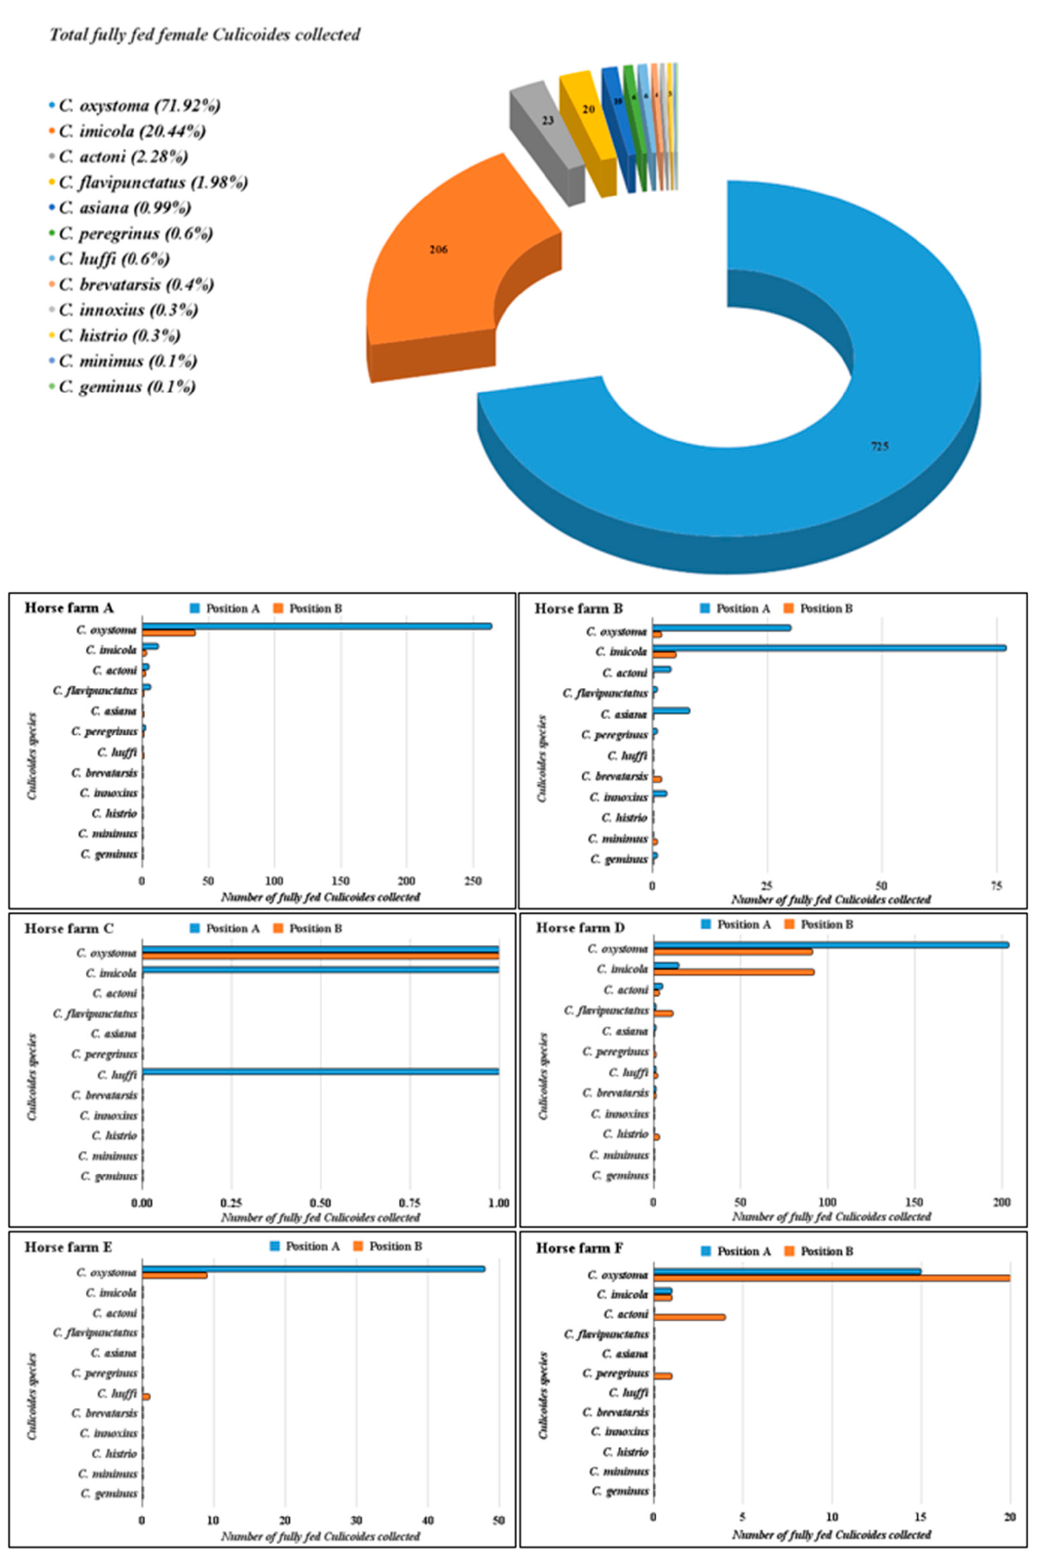
Figure 2. Number of Culicoides species collected from two positions at each horse farm in Hua Hin district, Prachuab Khiri Khan province, Thailand. Numbers in the pie chart are indicating numbers of each Culicoides species collected in this study.